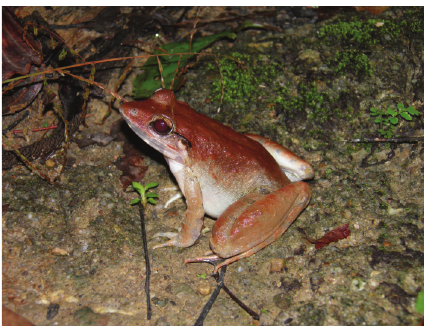
Figure 1: An adult Limnonectes blythii from Kedah, Peninsular Malaysia.